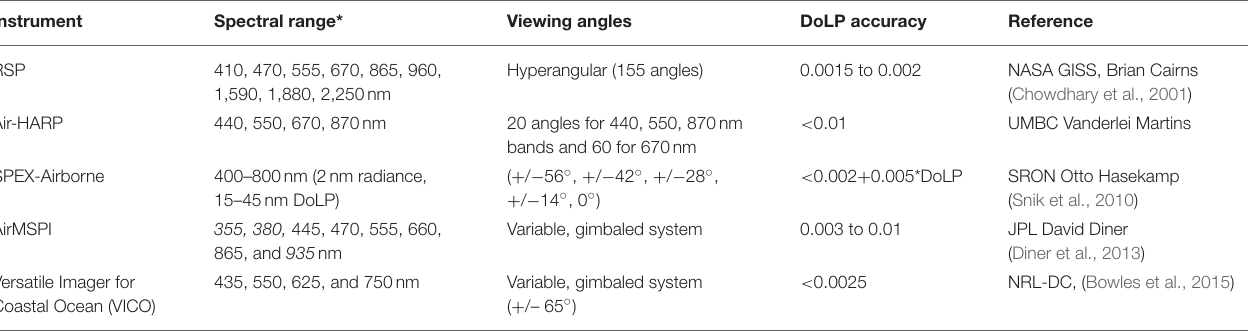
TABLE 3 | List of Multi-angular airborne polarimeters that can be used to develop and test algorithms.